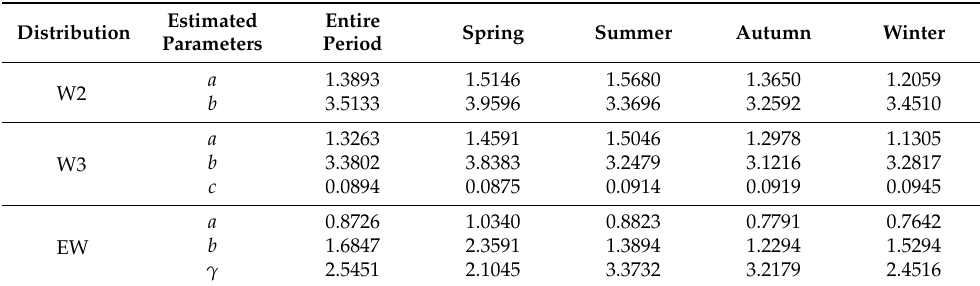
Table 5. Maximum likelihood estimates of parameters of the modelled distributions—the entire considered period and the